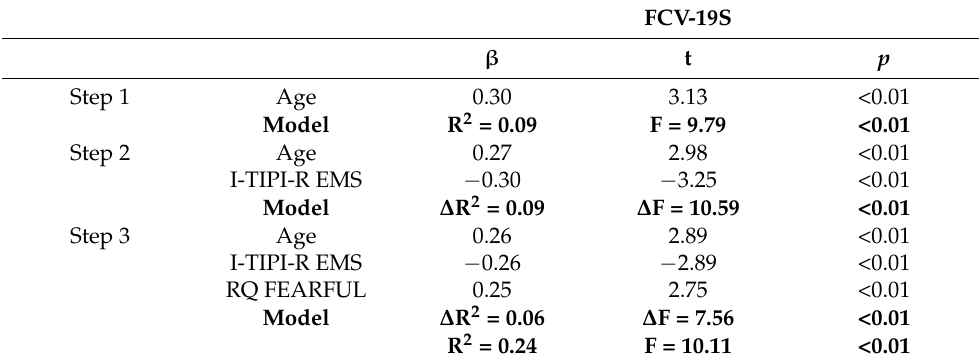
Table 2. Results of stepwise regression analysis with fear of COVID-19 (FCV-19S) as the dependent variable, and sociodemographic data (step 1), big five personality traits (I-TIPI-R) (step 2), and adult attachment style (RQ) (step 3) as independent